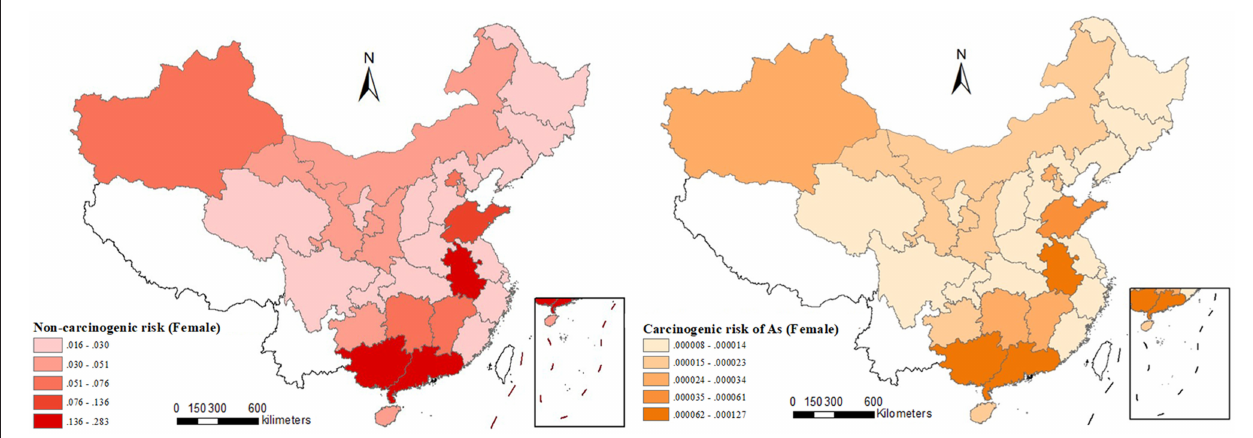
FIGURE 6 | Health risk of As pollution for adult females in agricultural regions. Data source: Yang et al. (81).